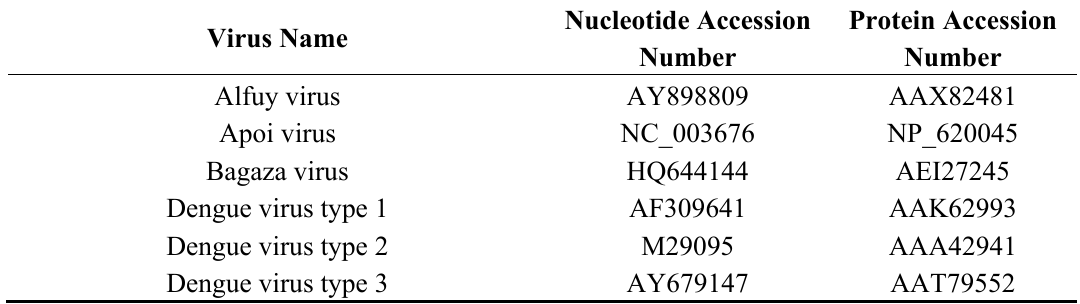
Table 2. Complete genome sequences and complete polyprotein precursor sequences used for the phylogenetic